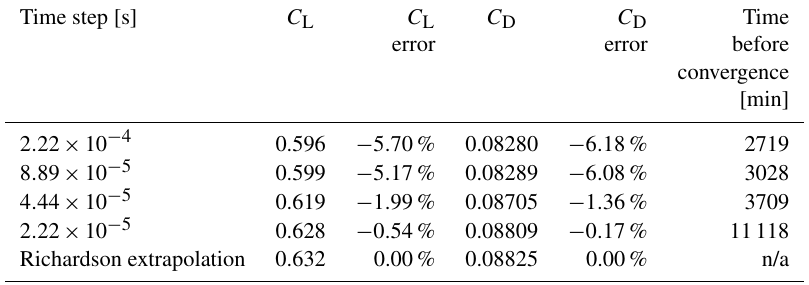
Table 3. Time step independence study for the scanned blade with spoiler at α = 0 ◦ and Re c = 3 × 10 6 .